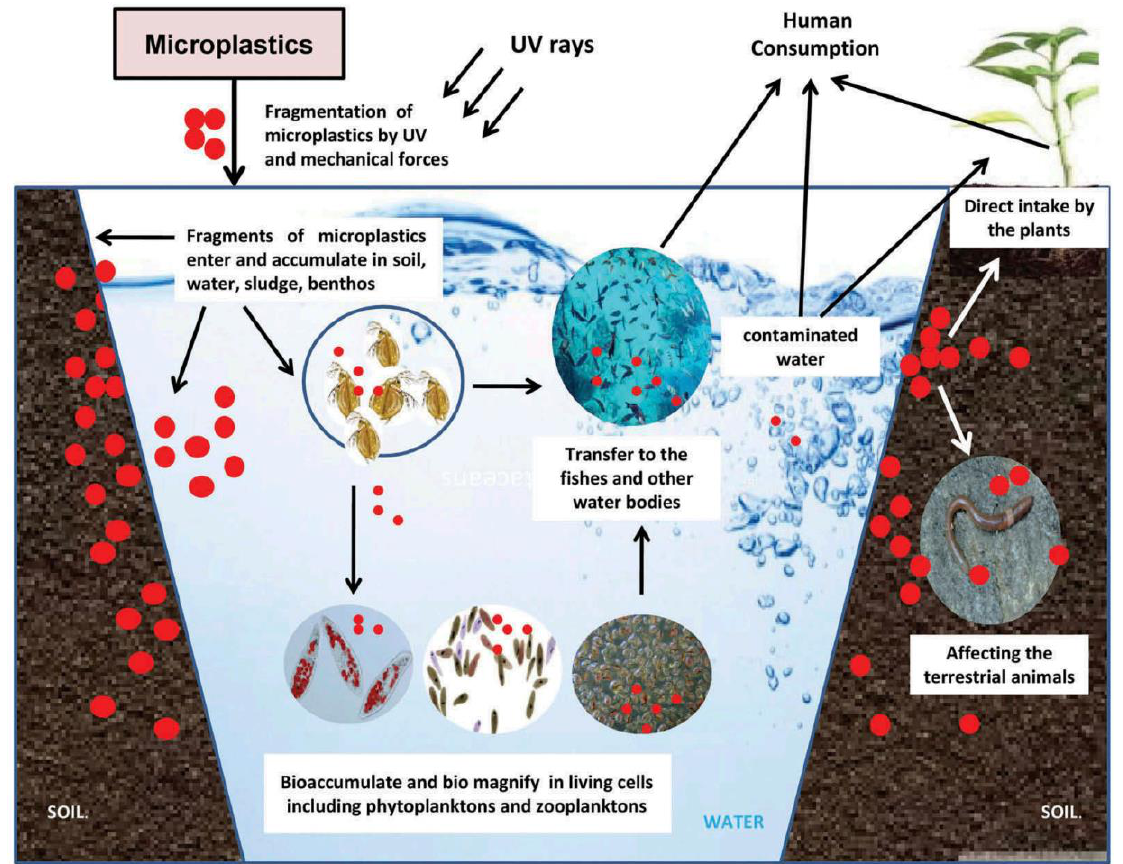
Figure 2. Schematic illustration of possible bioaccumulation and biomagnification of microplastics in water matrices. Reprinted from [86] with permission from Taylor & Francis. Copyright (2019) Informa UK Limited, trading as Taylor & Francis Group.